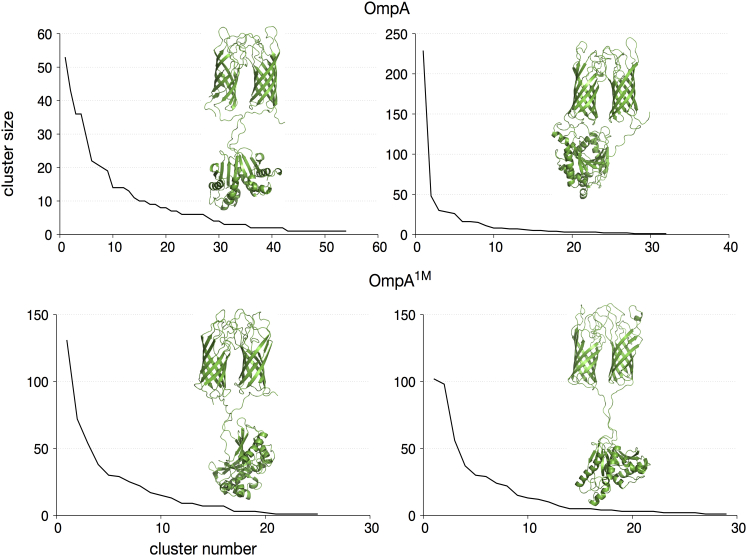
Cluster analysis for the OmpA dimer. The frequency of each cluster is shown, ordered from the most to least frequently sampled conformation. A representative structure of the most dominant cluster in each simulation is shown in the inset. To see this figure in color, go online.